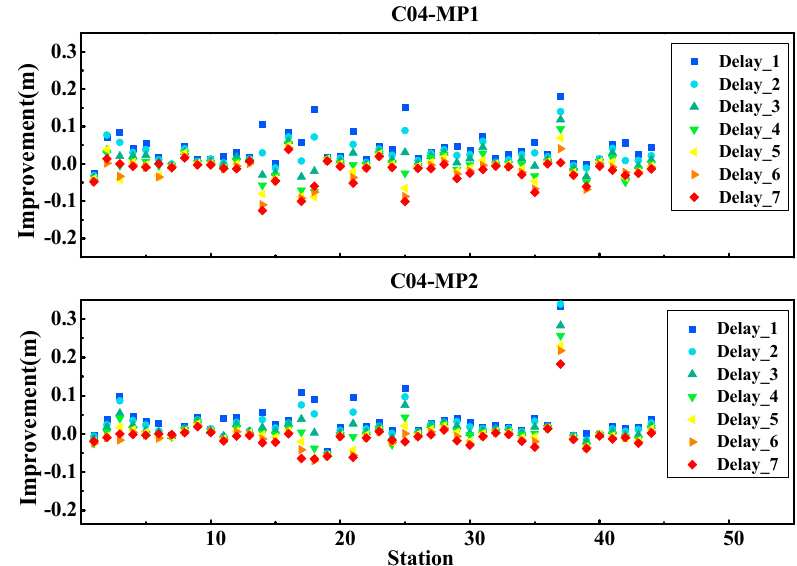
Figure 7. Improvement of the multipath series (RMSE) by correcting the multipath errors with different time delays (from one-day to seven-days).